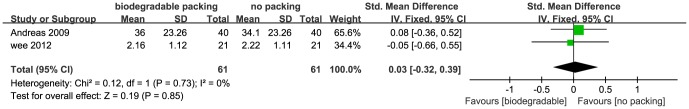
Forest plot of comparison: nasal blockage (biodegradable packings versus no packing).